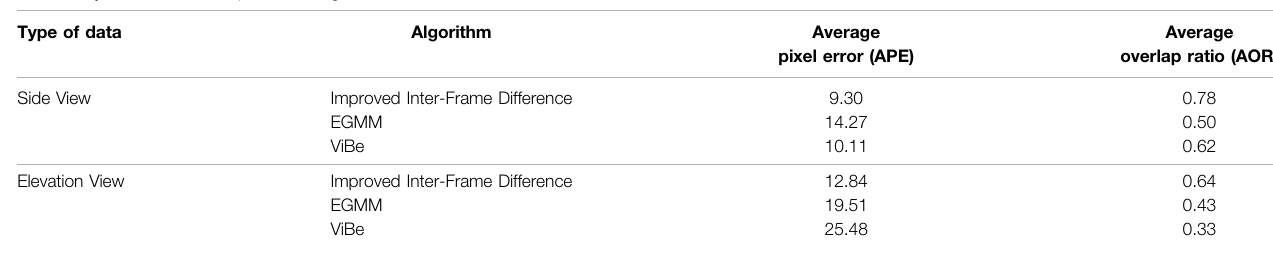
TABLE 2 | Performance comparison of